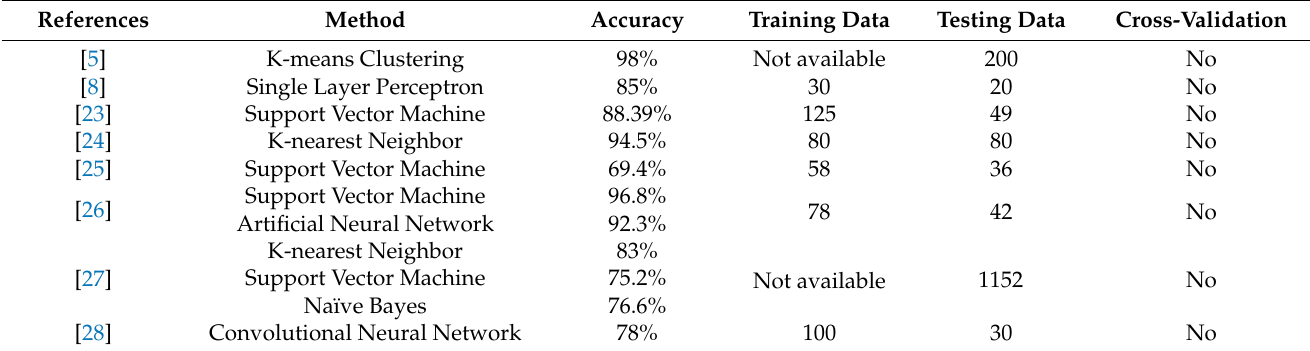
Table 6. Numerical results of related studies using digital camera images.